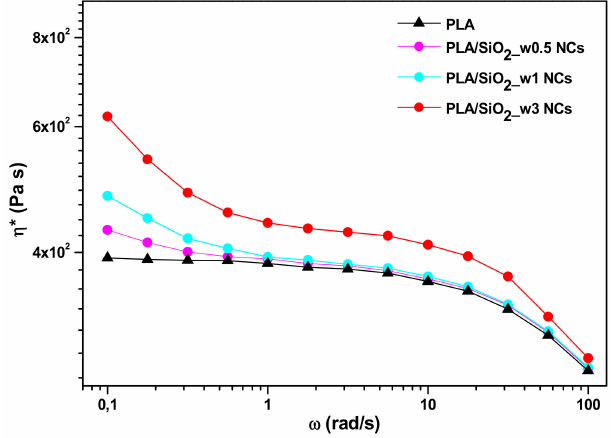
Figure 11. Complex viscosity as a function of frequency at 180 ◦ C for all investigated